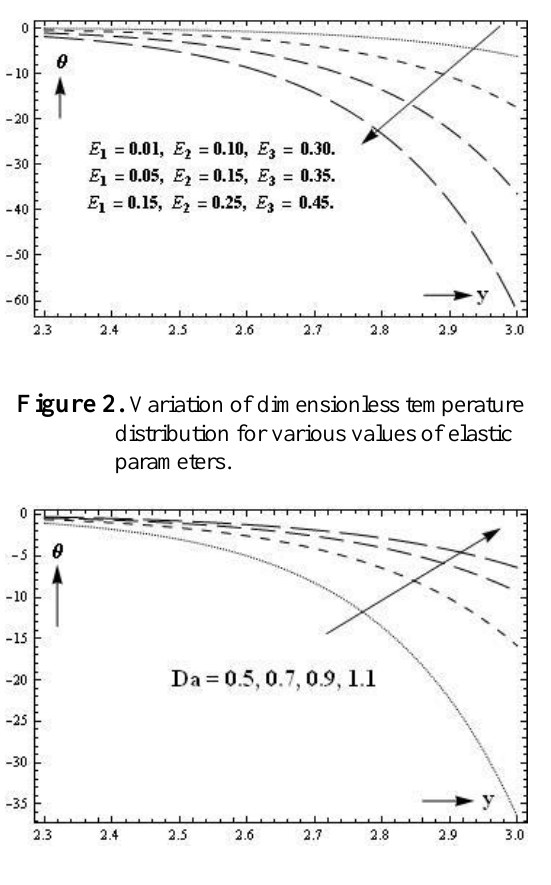
Figure 4. Variation of dimensionless temperature distribution for various values of Darcy number.